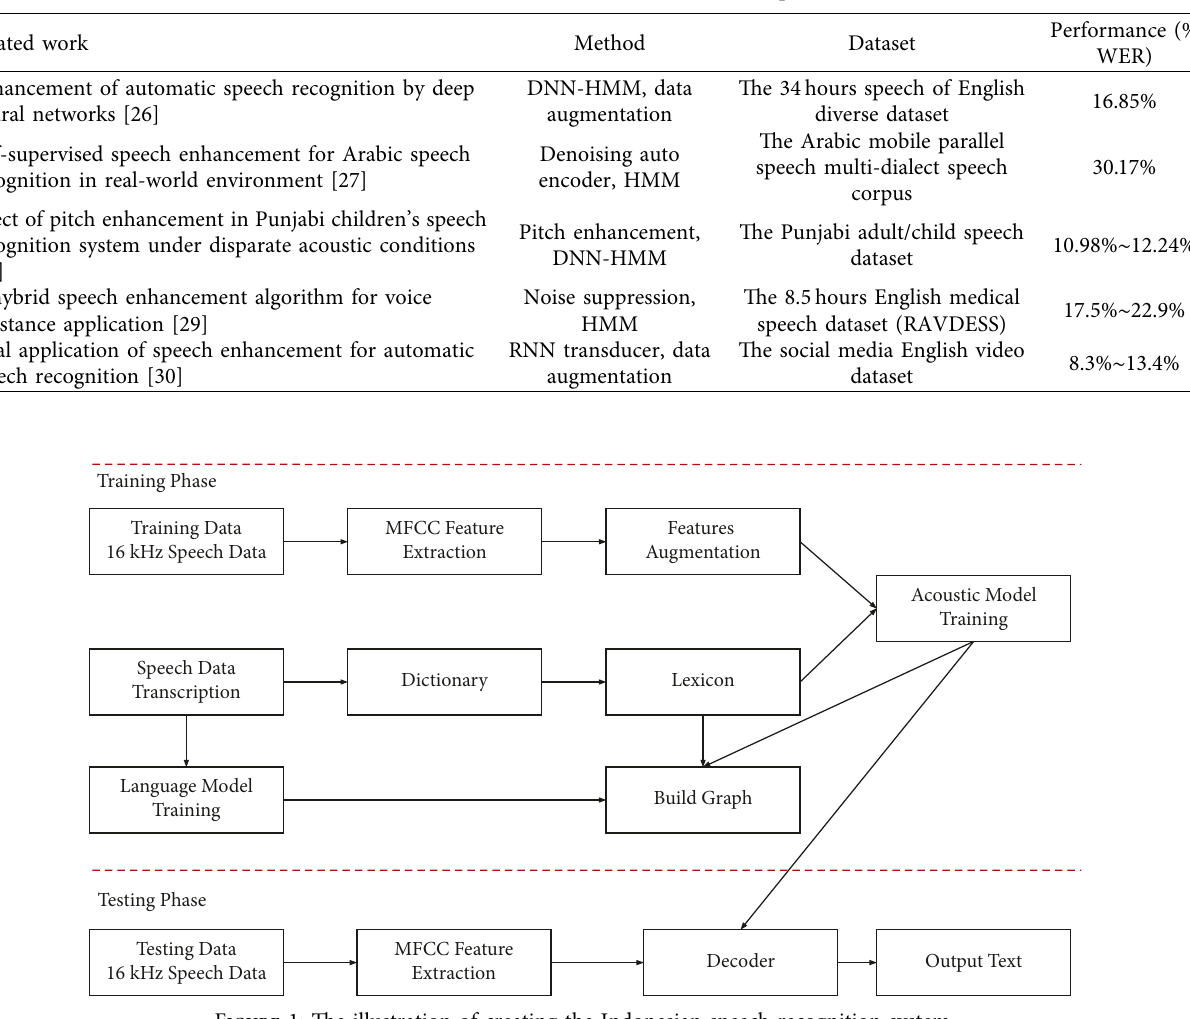
Table 1: The methods in the literature, dataset used, and their performance [26–30].